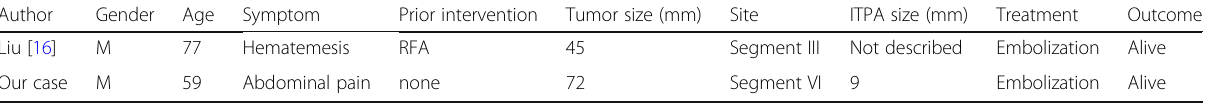
Table 1 Clinical characteristics of patients with ITPA within a liver metastasis of gastric cancer